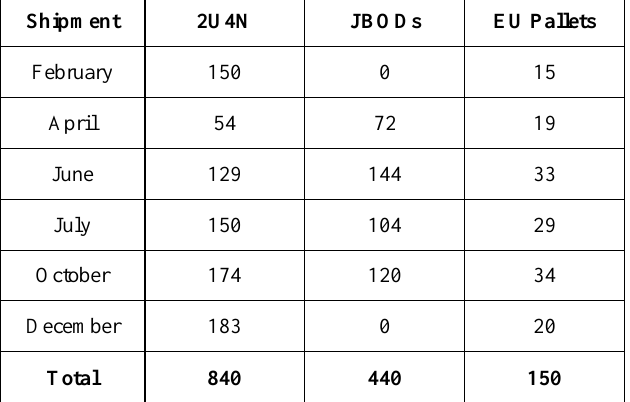
Table 1: Repatriation of IT equipment from Wigner to CERN in 2019. Shipment 2U4N JBODs EU Pallets February 150 0